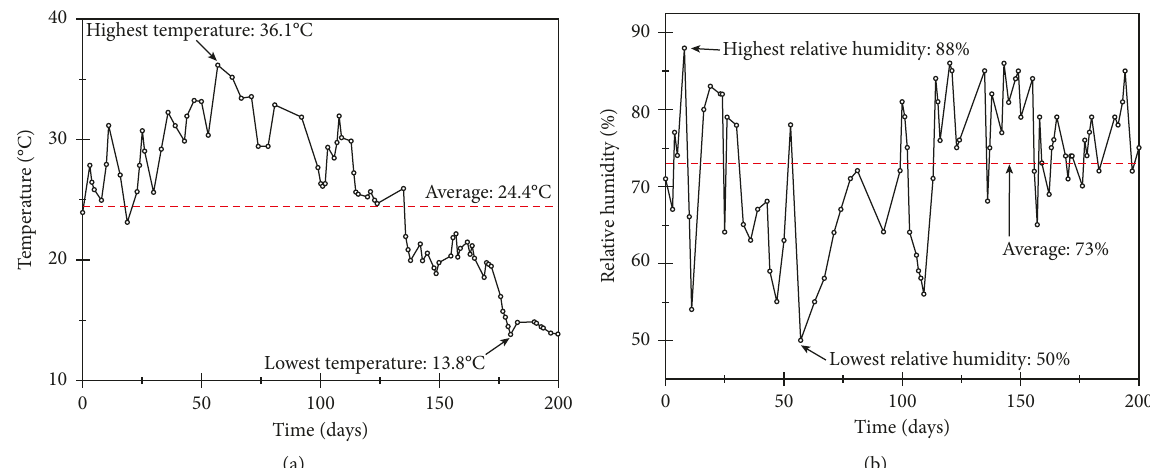
Figure 3: Environmental conditions during test. (a) Temperature indoors. (b) Relative humidity